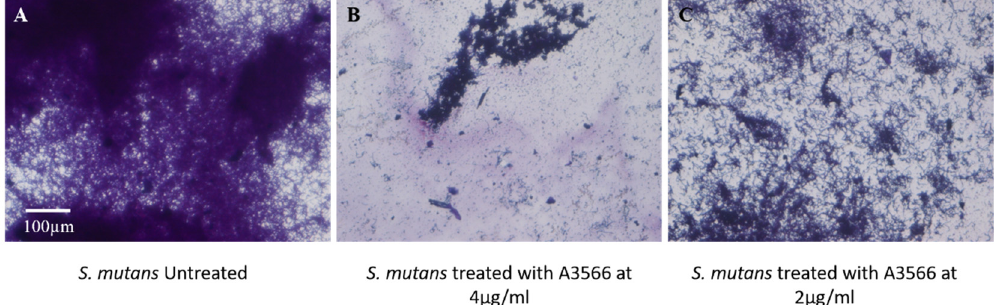
Figure 5. Biofilm inhibition potential of LN 3566 against S. mutans . ( A ) Untreated control, ( B ) treated with A3566 at 4 µ g/mL, ( C ) treated with LN 3566 at 2 µ g/mL. Images were captured using a Nikon TE2000 inverted microscope with 200 × total